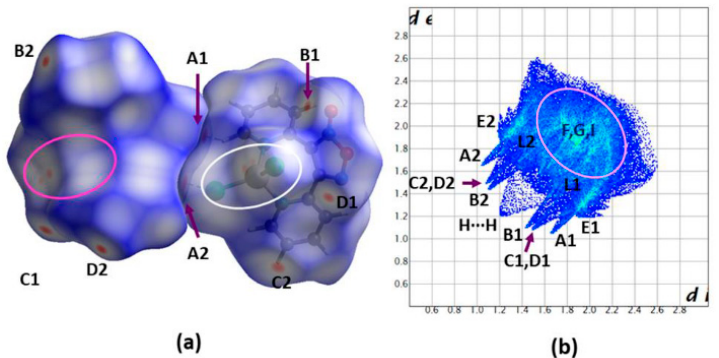
Figure 3. Two centrosymmetrically related hydrogen-bonded [ZnCl 2 (L)] molecules that are present in the crystal structure of 1 . The thermal ellipsoids are presented at the 50% level. The light green dashed lines indicate the C1–H1 ⋯ Cl1 ′ and C1 ′ –H1 ′ ⋯ Cl1 hydrogen bonds. The hydrogen atoms are not labelled. Symmetry codes: (‘) − x , − y + 2, − z + 1.